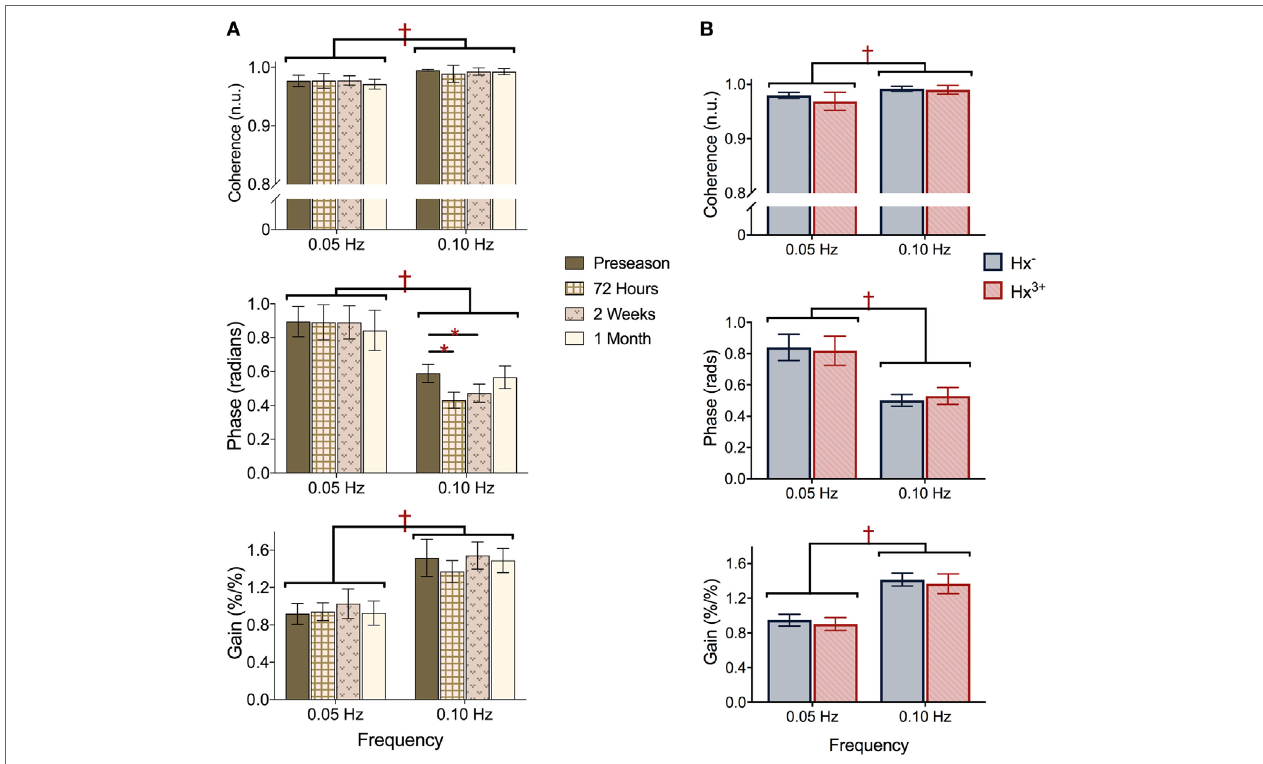
FigUre 3 | Transfer function analysis outcomes Coherence (top), Phase offset (middle), and normalized Gain (bottom) during squat–stand maneuvers assessed at (a) preseason and each post-concussion time point; (b) preseason in athletes with zero and three or more previous concussions. † represents significant main effect of frequency ( p all < 0.01), *denotes significant simple effect of time ( p all < 0.01). Data presented as mean ± SE.